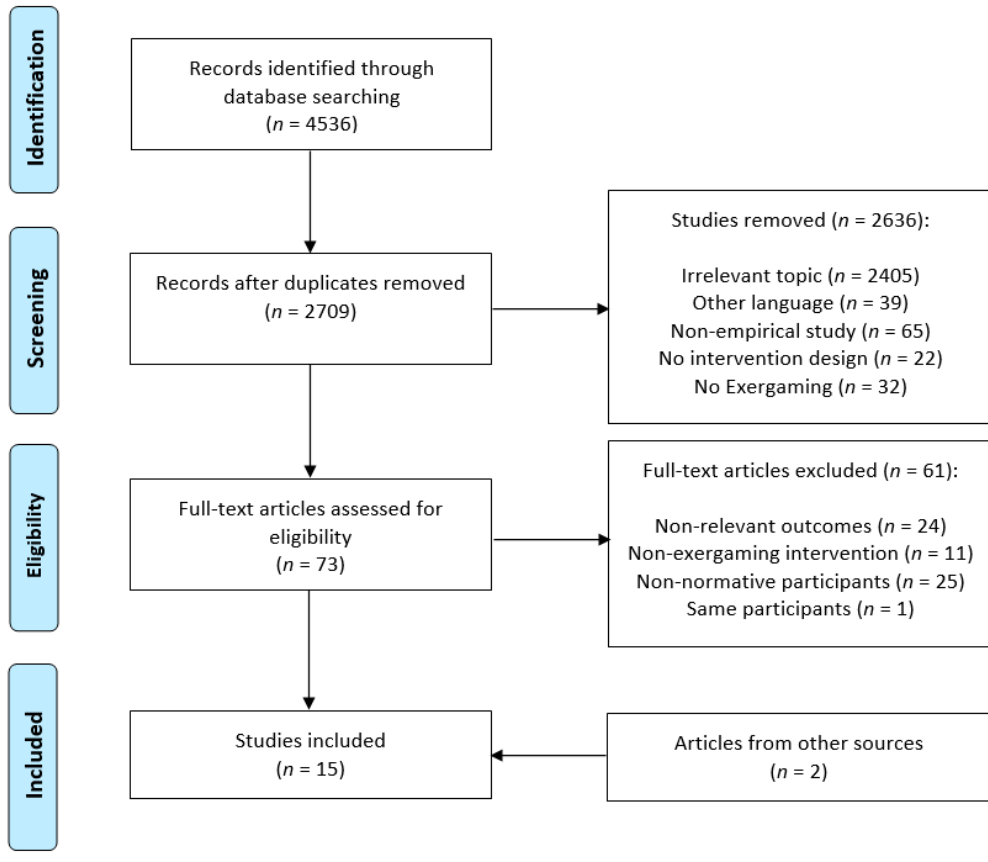
Figure 1. PRISMA flow chart of the search process.